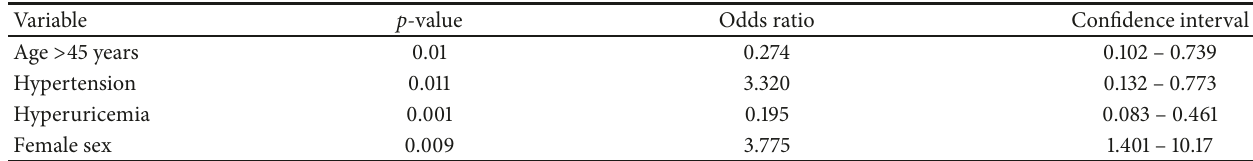
Table 2: Bivariate analysis of factors associated with